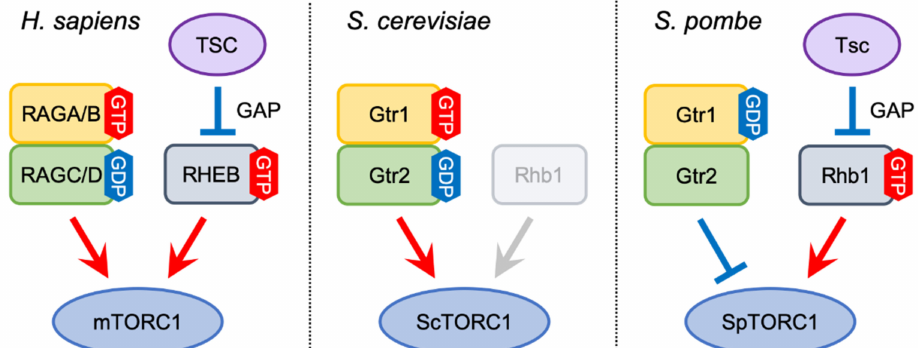
Figure 2. TORC1 regulation by two classes of GTPases. In mammals, the active form of the RAG heterodimer (RAGA/B GTP - RAGC/D GDP ) mediates mTORC1 activation by recruiting mTORC1 to lysosomes, where RHEB directly stimulates mTORC1 kinase activity. RHEB is negatively regulated by the TSC complex through its GAP activity. In budding yeast, the Gtr1 GTP - Gtr2 GDP heterodimer also promotes ScTORC1 activation. On the other hand, Rhb1, a RHEB ortholog, is not involved in ScTORC1 regulation, and TSC orthologs are absent in the budding yeast genome. Like mammalian RHEB, fission yeast Rhb1, which is negatively by the Tsc1-Tsc2 complex, is an essential activator of SpTORC1, whereas the Gtr heterodimer with GDP-bound Gtr1 plays a role in attenuating SpTORC1 activity. The guanine-nucleotide binding state of fission yeast Gtr2 does not appear to be important for SpTORC1